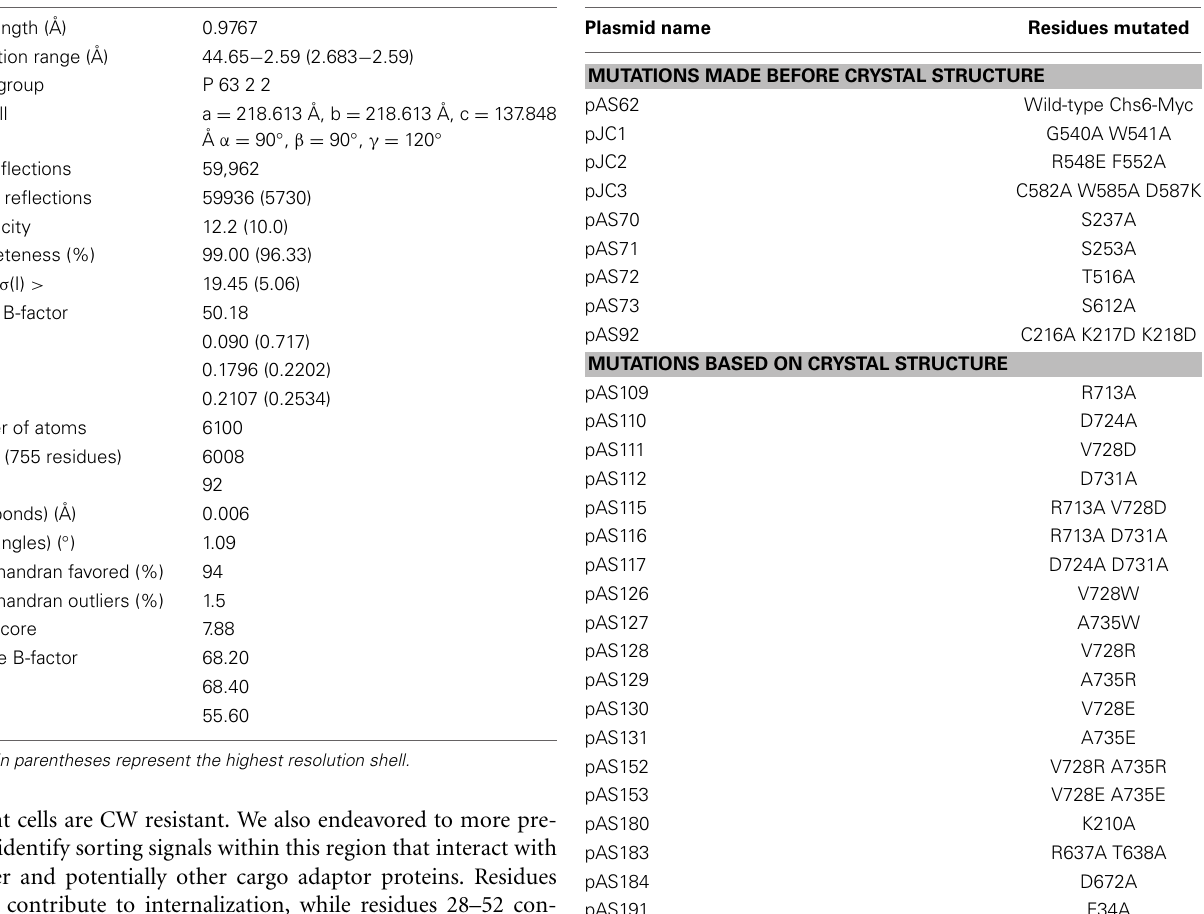
Table 1 | Crystallographic statistics. Table 2 | Many Chs6 mutations have no